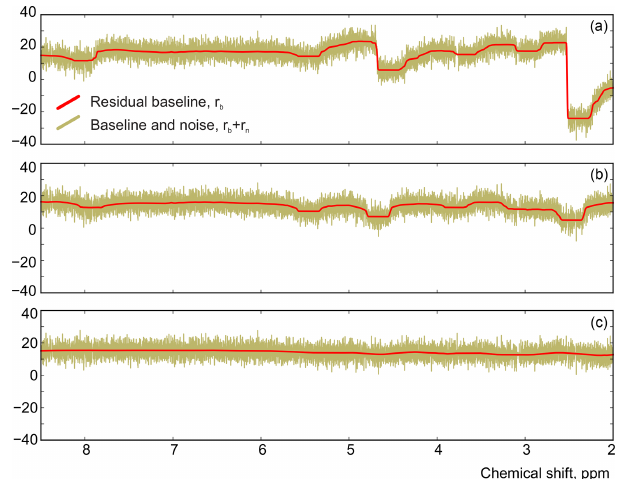
Figure 8. The residual signals before (a) and after (b) adjusting the phase parameters using a median filter with size m w ≈ 100 · FWHM. (c) The result of applying a wider filter with m w ≈ 400 · FWHM.